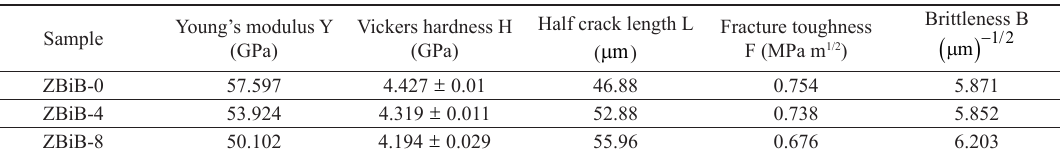
Table 3. Young’s modulus, Half crack length, Vickers hardness values, fracture toughness and brittleness of selected glass sample at 9.8 N load. Sample